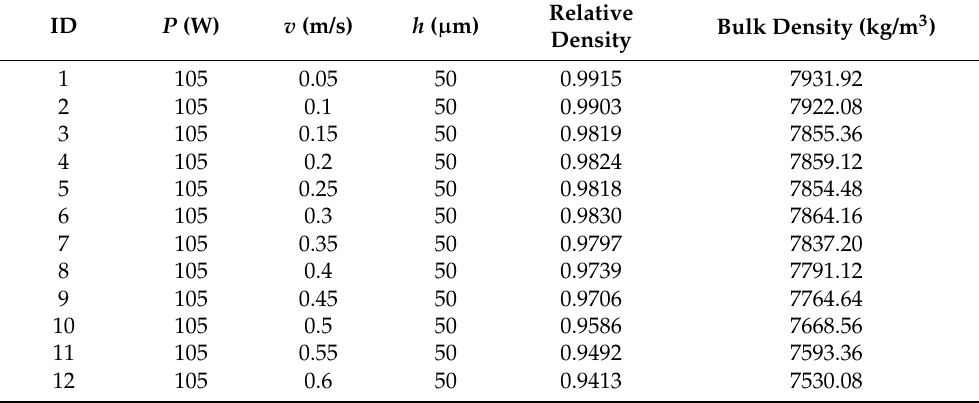
Table A10. Manufacturing parameters and experimental data adapted from [24]. Complement- ing relevant information and assumptions are the following; material: SS304L, theoretical